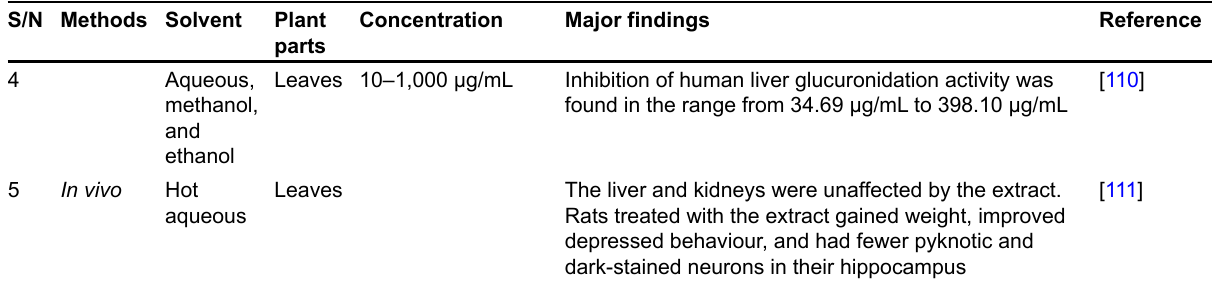
Table 7. Wound healing activity of FD ( continued ) S/N Methods Solvent Plant Concentration Major findings parts